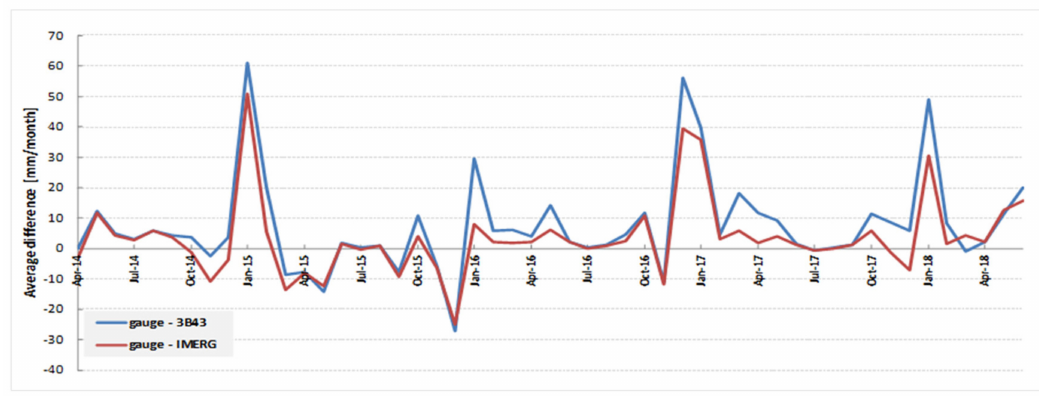
Figure 4. Average di ff erence (monthly values) between gauge stations data from 3B43 (blue line) and IMERG (red line) estimates, respectively.